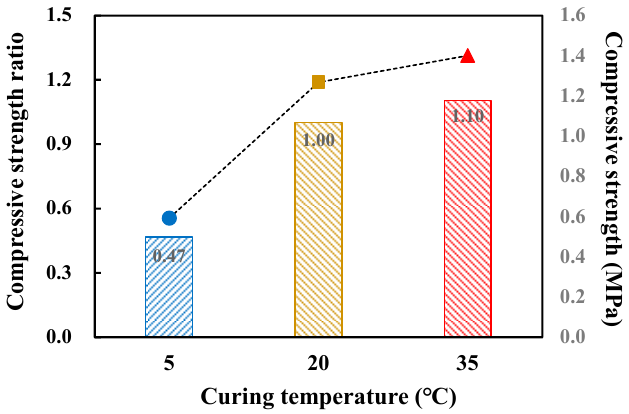
Figure 8. Compressive strength measurement results according to curing condition of red clay binder specimens at 24 h.